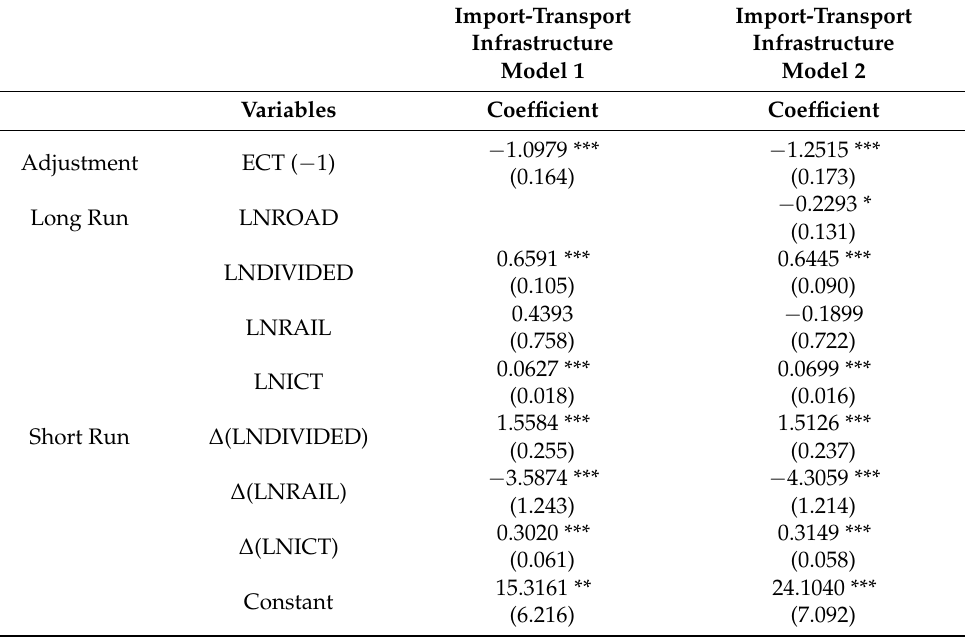
Table 6. ARDL models for